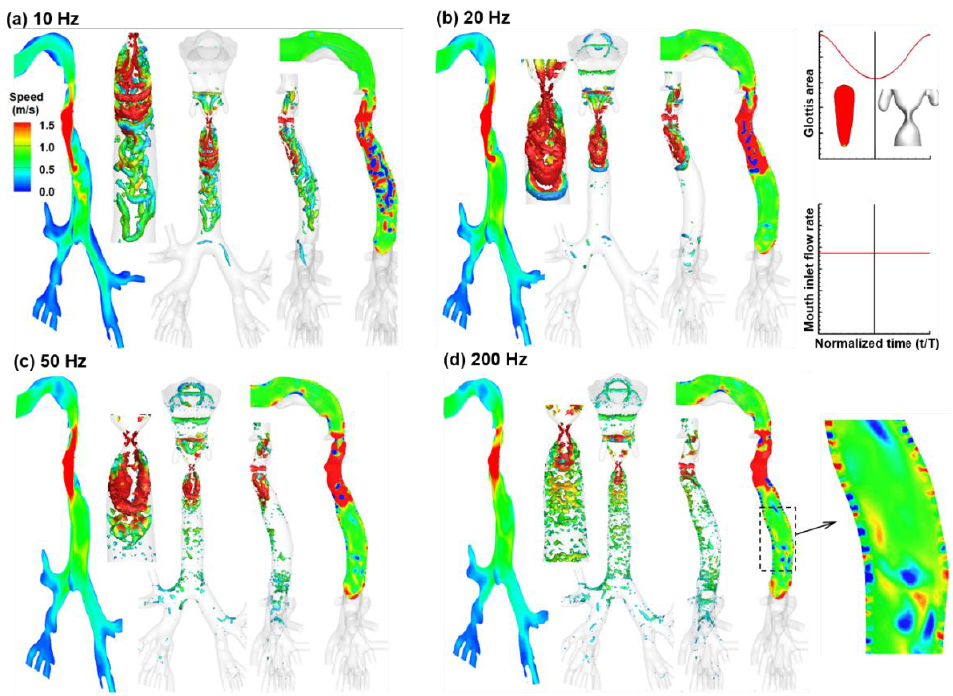
Figure 2. Respiratory flow dynamics in the upper airway with different glottal vibration frequencies ( f 0 ): ( a ) 10 Hz, ( b ) 20 Hz, ( c ) 50 Hz, and ( d ) 200 Hz.